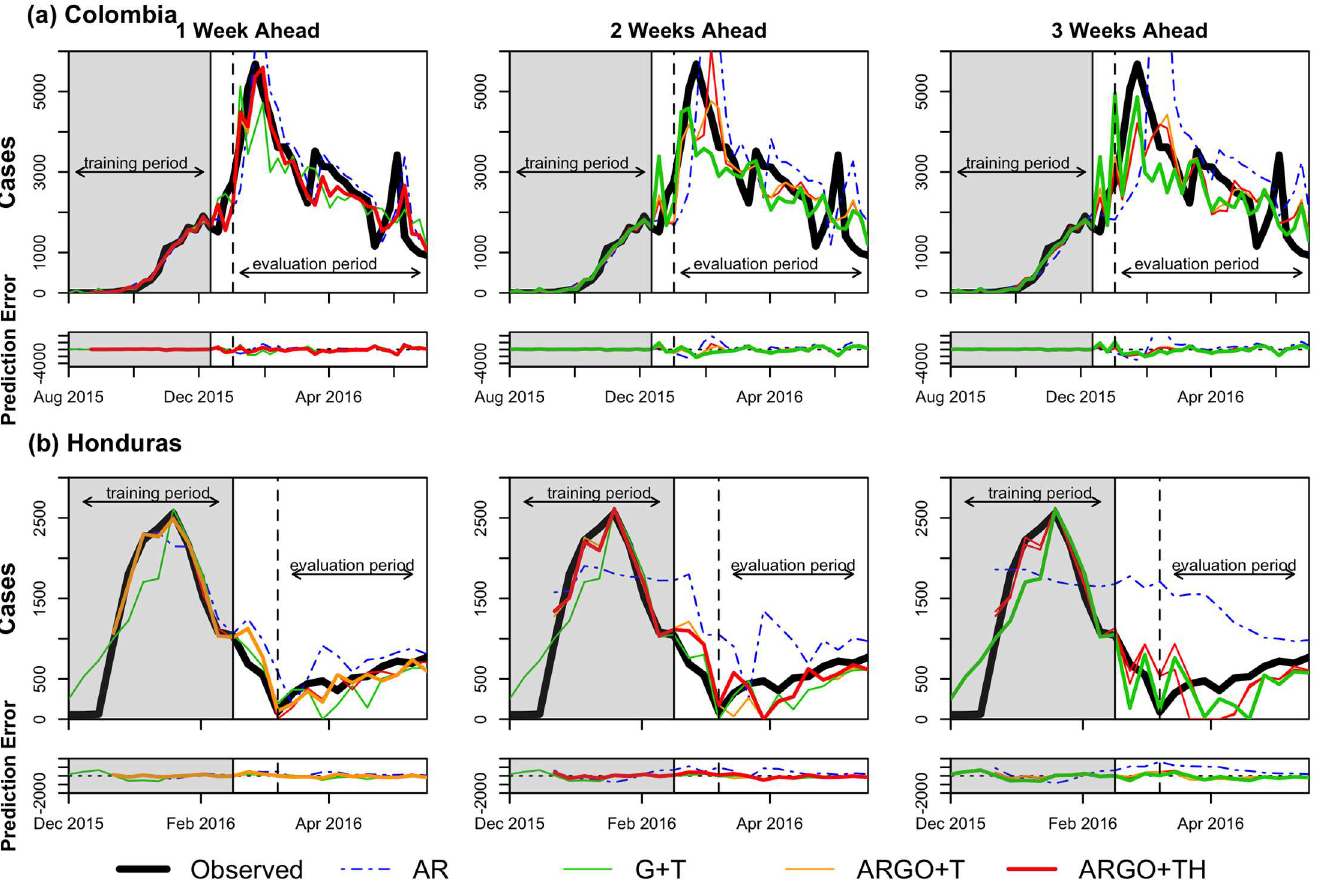
Fig 1. Prediction results for (a) Colombia and (b) Honduras. In each country, the weekly estimationsof AR (dotted blue), G+T (green), ARGO+T (orange),and ARGO+TH (red) models are comparedto the official case counts (black). Models includeTwitter data where available(Colombia). The best model performance (lowest relative RMSE) in each time series by country is shown as a